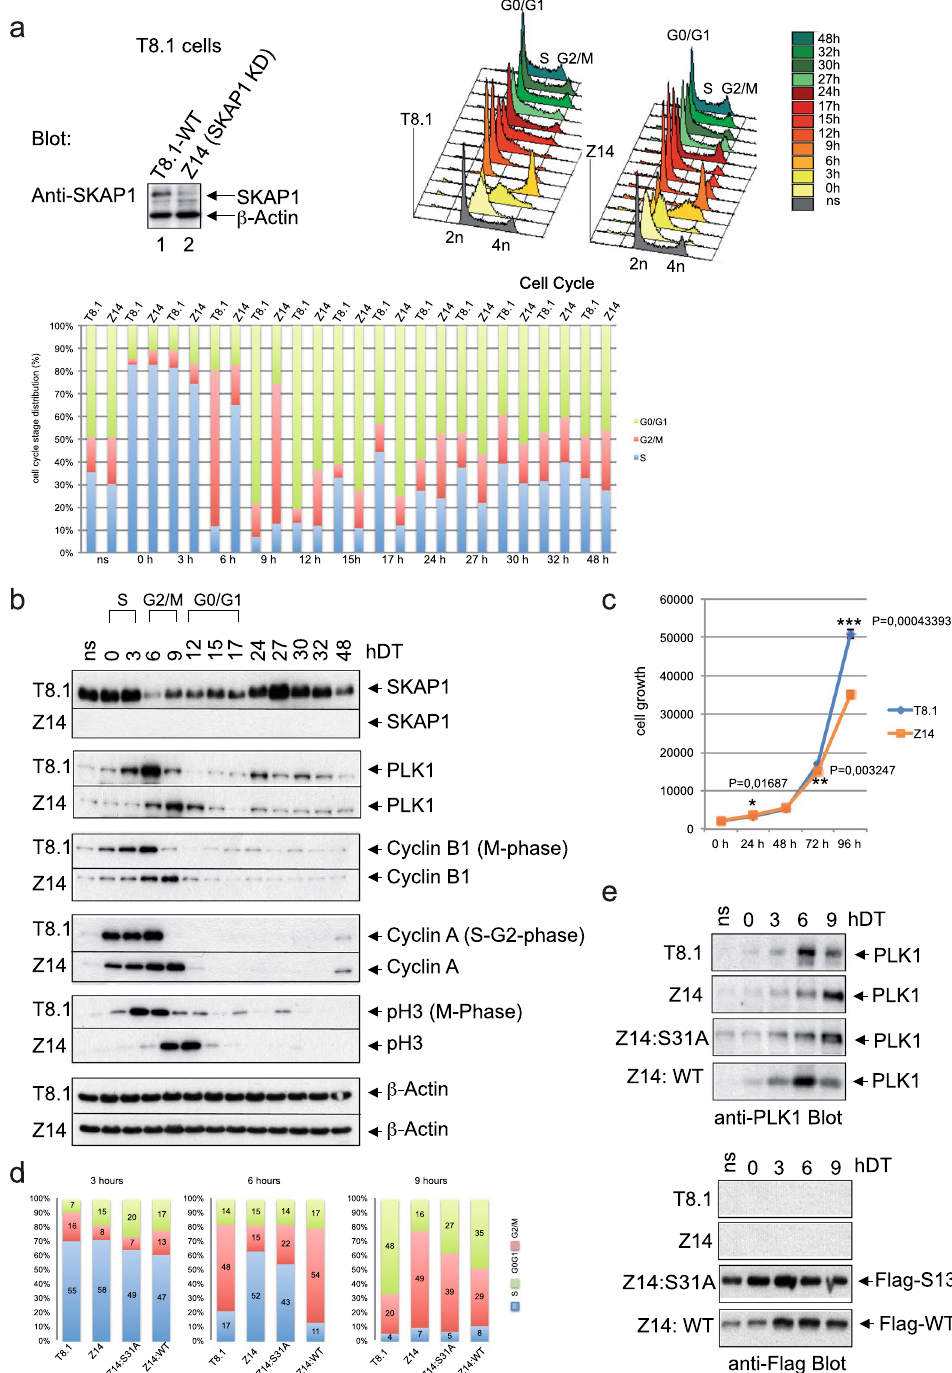
Figure 7. SKAP1 regulates cell cycle of T-cells. (Panel a) SKAP1 shRNA knock-down of T-cells delays T-cell cycle progression. Cells were subjected to double thymidine (DT) labelling to monitor the kinetics of cell cycle progression. Upper left inset: shows down-regulation of SKAP1 expression in T-cells by SKAP1 shRNA. Right upper panel: FACS profile of DT synchronized mouse WT (T8.1) and SKAP1 KD Z14 T cells. Middle lower panel: Histogram showing percentages of cells which were in the G0/G1, G2/M and S phase. (Panel b) SKAP1 shRNA knock-down T-cells show a delay in expression of key regulators or cell cycle progression. The expression of regulators of cell cycle such as Cyclin B1 (M- phase), Cyclin A (S-G2 phase), pH3 (M phase) in wild-type cells versus Z14 cells by immunoblotting of cell lysates. (Panel c) Growth curve of SKAP1 WT T cells and SKAP1 shRNA knock-down T cells over a period of 96 hours. Z14 T cells show a lower cell number relative to T8.1 WT cells. (Panel d) SKAP1 WT, but not SKAP1-S31A, rescues Z14 T-cells for normal cell cycle. Z14 T cells, transfected with either Flag-SKAP1 WT or a S31A mutant, were synchronized by double